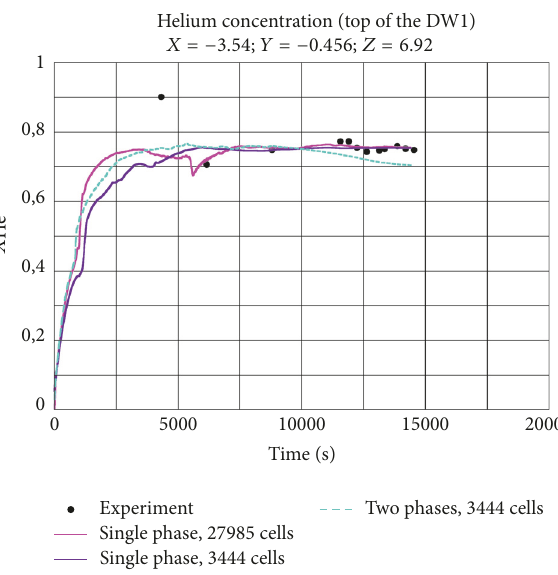
Figure 12: Helium concentration at the middle of DW1.